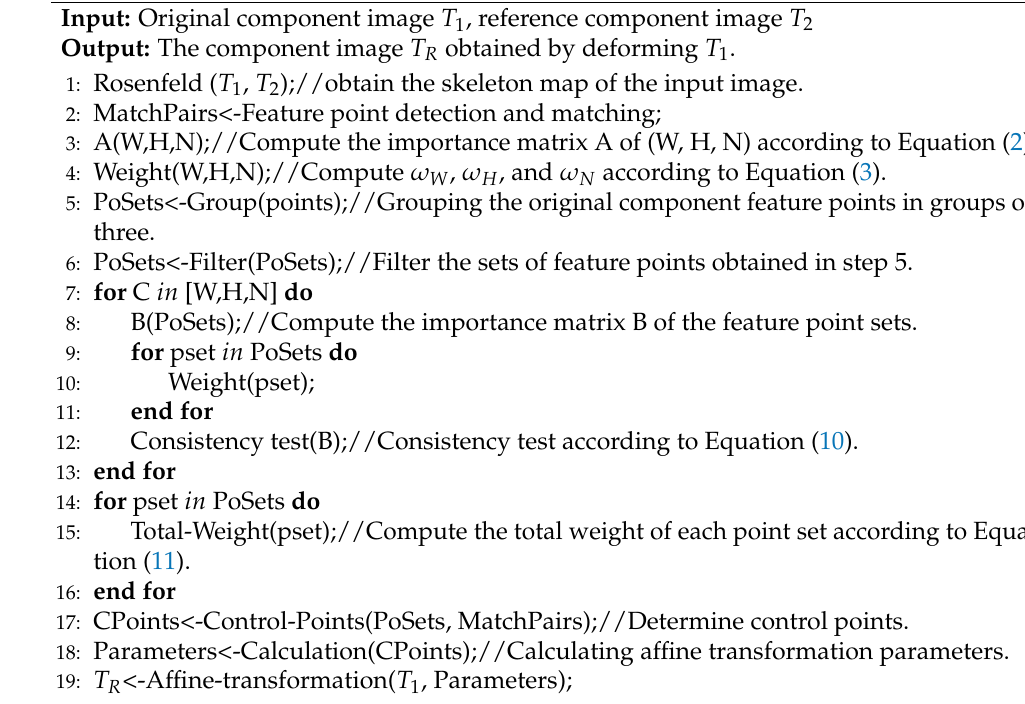
Algorithm 1 AHP-based Chinese character component